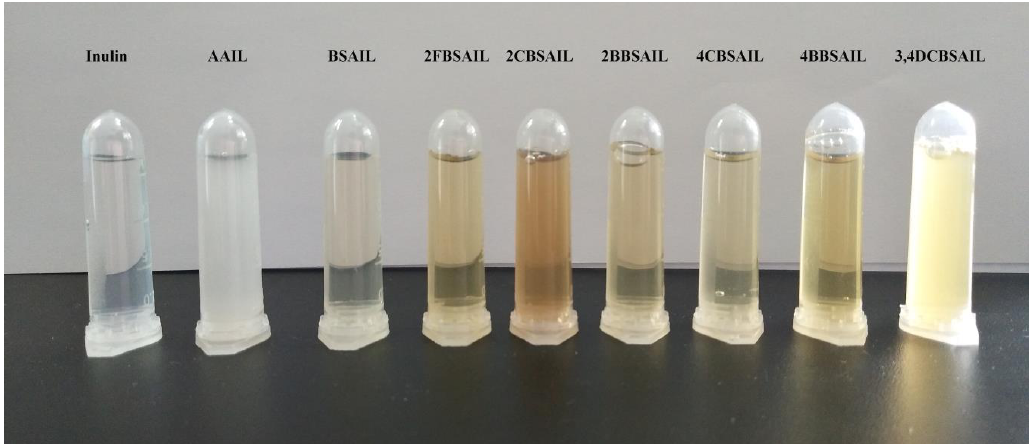
Figure 5. The water solubility of inulin, AAIL, and inulin derivatives at 1.0 mg/ mL, room temperature.